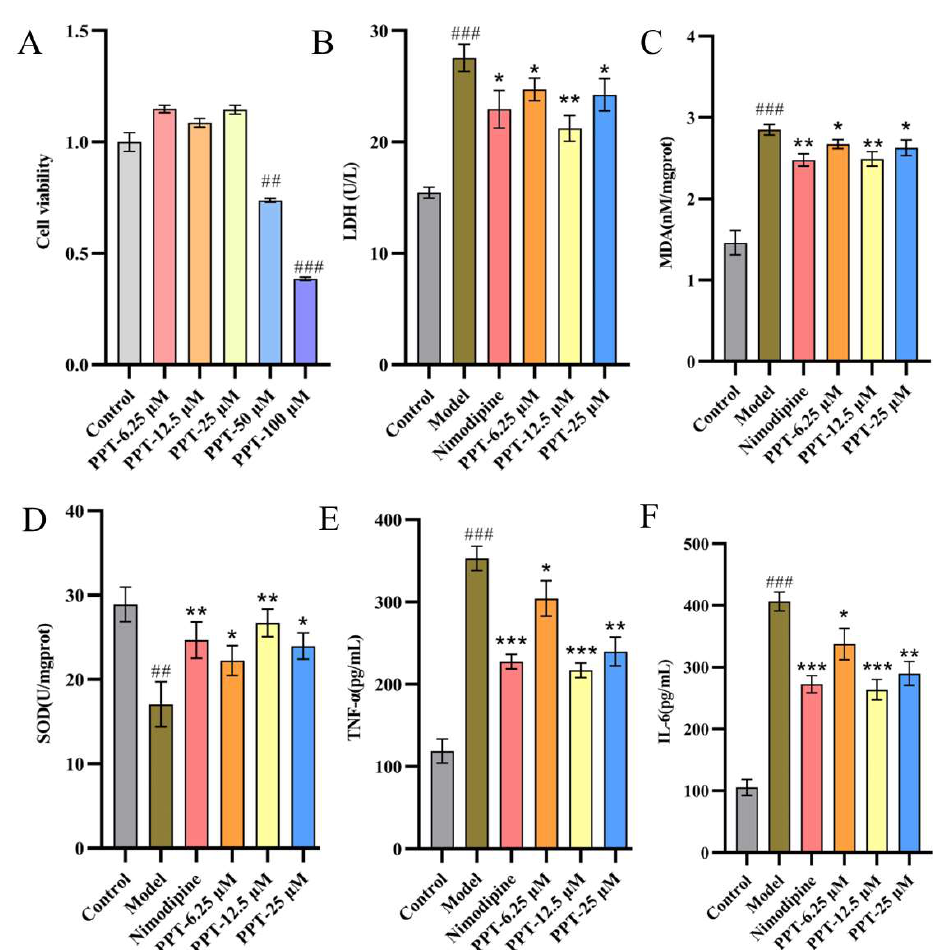
Int. J. Mol. Sci. 2023 , 24 , x FOR PEER REVIEW